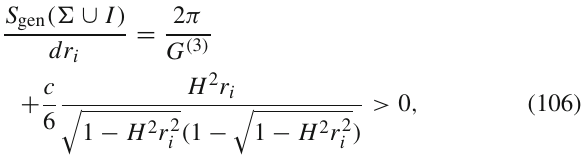
Regions satisfying ∂ U S gen ( I ) ≥ 0 in condition 2, ∂ V S gen ( I ) ≤ 0 in condition 2, and ∂ U S gen ( G ) ≤ 0 condition 3 are colored in orange, green and red, respectively. Regions allowed by ∂ V S gen ( I ) ≤ 0 and ∂ ( G ) ≤ 0 do not overlap. The region satisfying condition 1 is not U S gen shown since it is the same as the case of dc / dr i = 0 and satisfied in the whole region Hr i < 1 except for tiny region around Ht i (cid:11) 0 and Hr i (cid:11) 1. The region allowed by ∂ V S gen ( G ) ≥ 0 in condition 3 is not shown as well since it is trivially satisfied for Hr i <